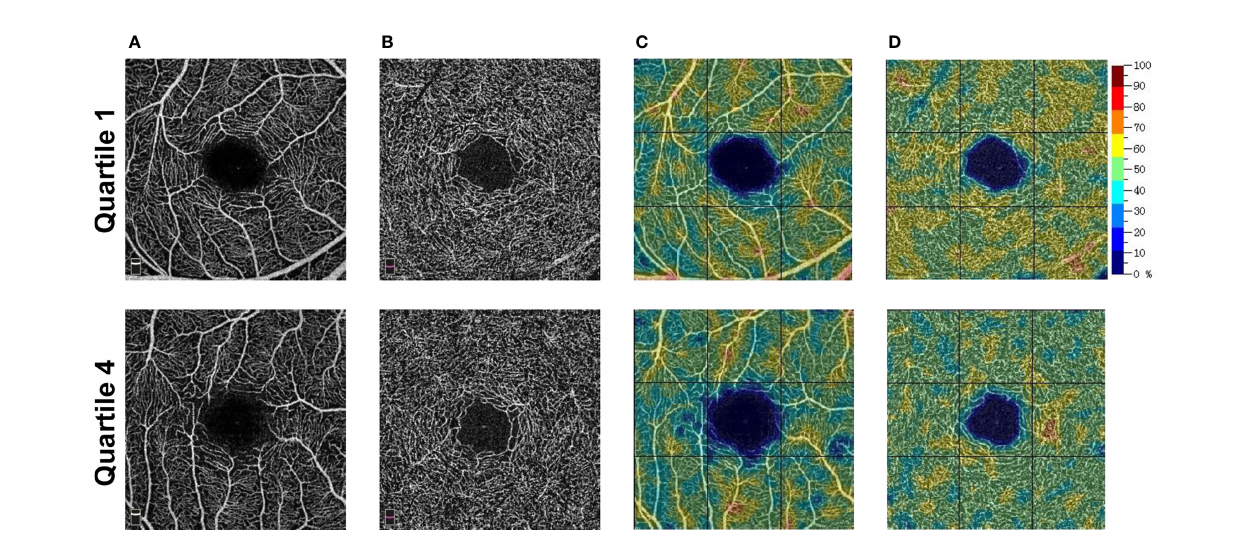
FIGURE 2 | Representative OCTA images of male participants. (A) The super fi cial OCT angiograms. (B) The deep OCT angiograms. (C) The color-coded super fi cial RCP vessel density maps. (D) The color-coded deep RCP vessel density maps. Quartile 1, SUA level ≤ 335 umol/L; Quartile 4, SUA level ≥ 444 umol/L. OCTA, optical coherence tomography angiography; OCT, optical coherence tomography; SUA, serum uric acid; RCP, retinal capillary